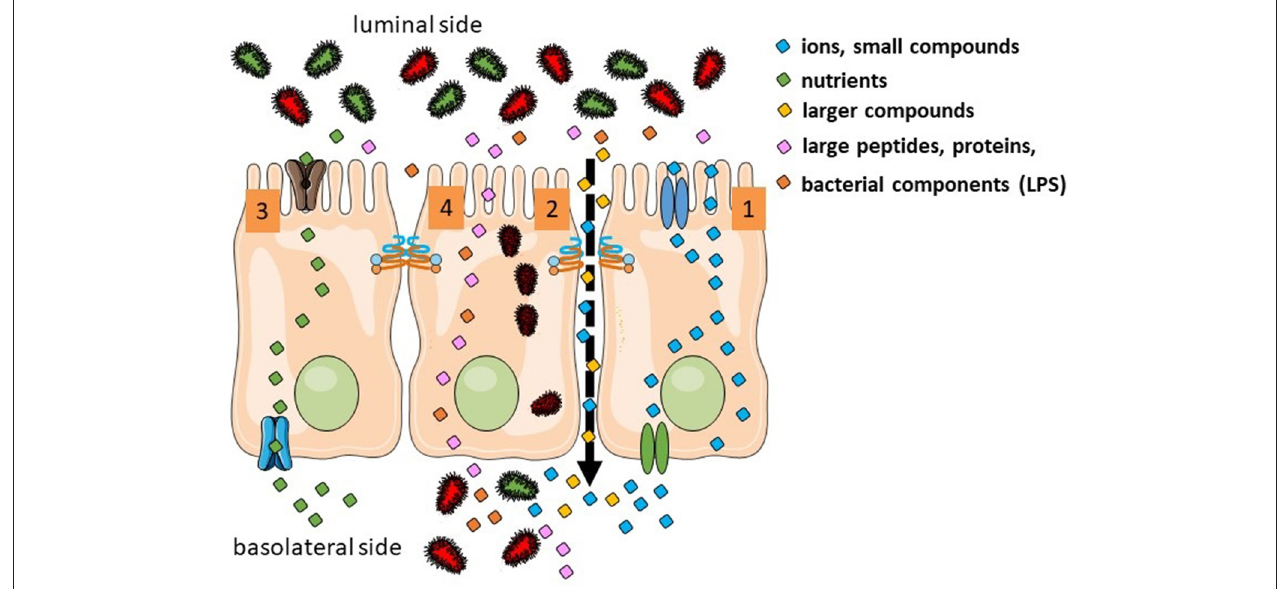
FIGURE 1 | Transport routes in the intestinal epithelium. Transcellular transport of ions is controlled by transporters in the apical and basolateral surfaces (1). Ion, water, and larger hydrophilic compounds use the paracellular pathway (2). Sugars, amino acids, and vitamins use active transport (3). Large molecules and whole bacteria are endocytosed into vesicles